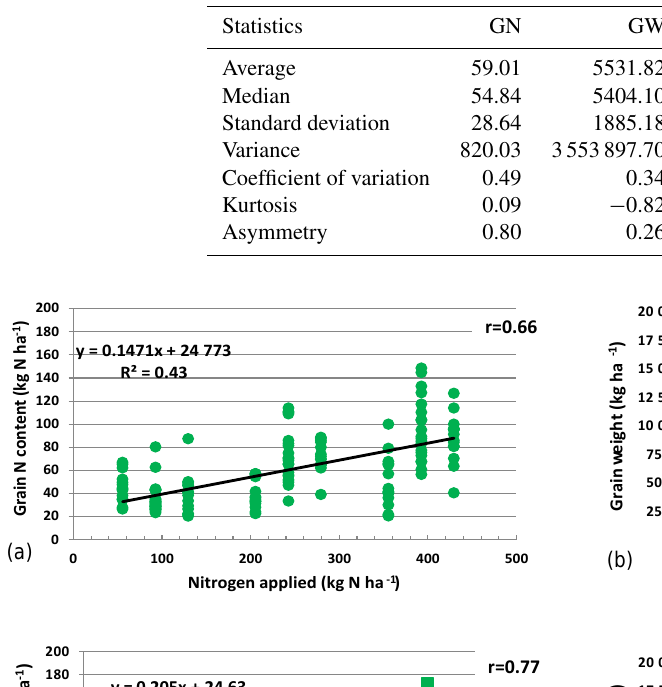
Table 2. Descriptive statistics of variables studied: grain N content (GN), grain weight (GW), wheat N content (PN) and wheat weight (PW).